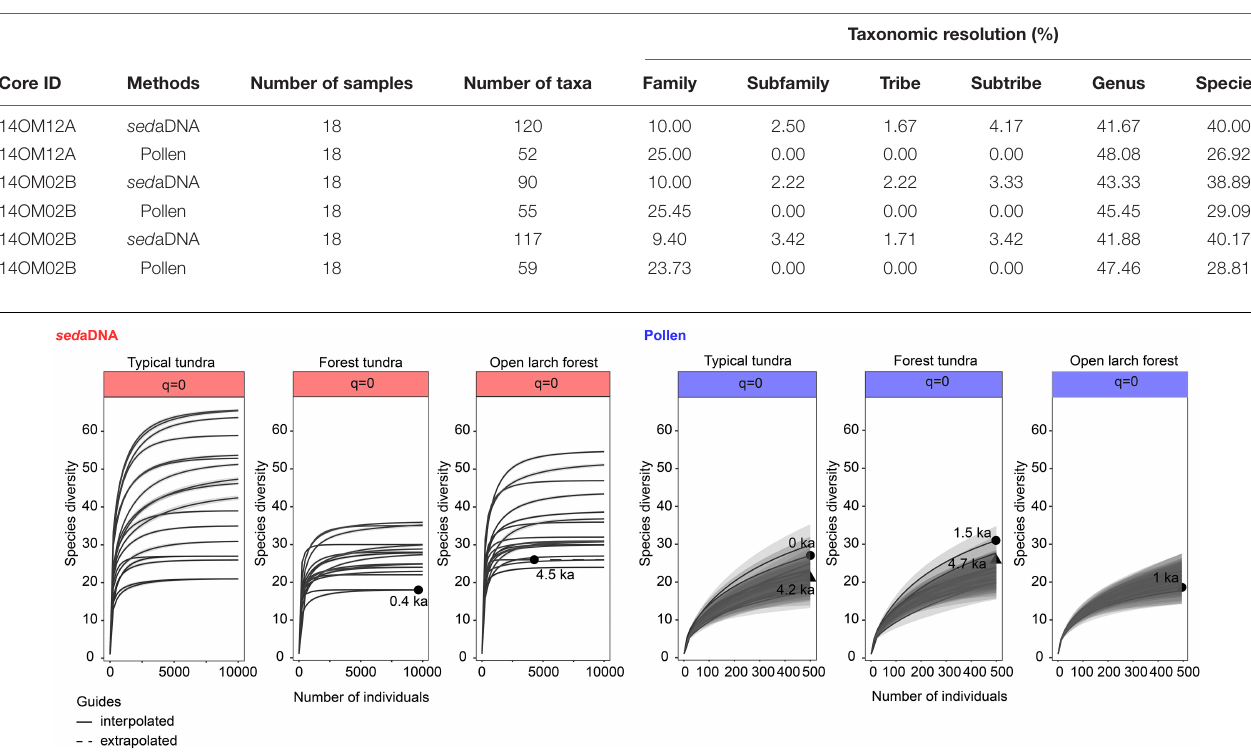
TABLE 5 | Summary of the taxonomic resolution of the sed aDNA and pollen approaches.